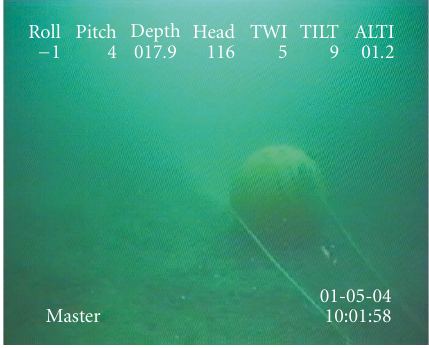
Figure 2: Initial